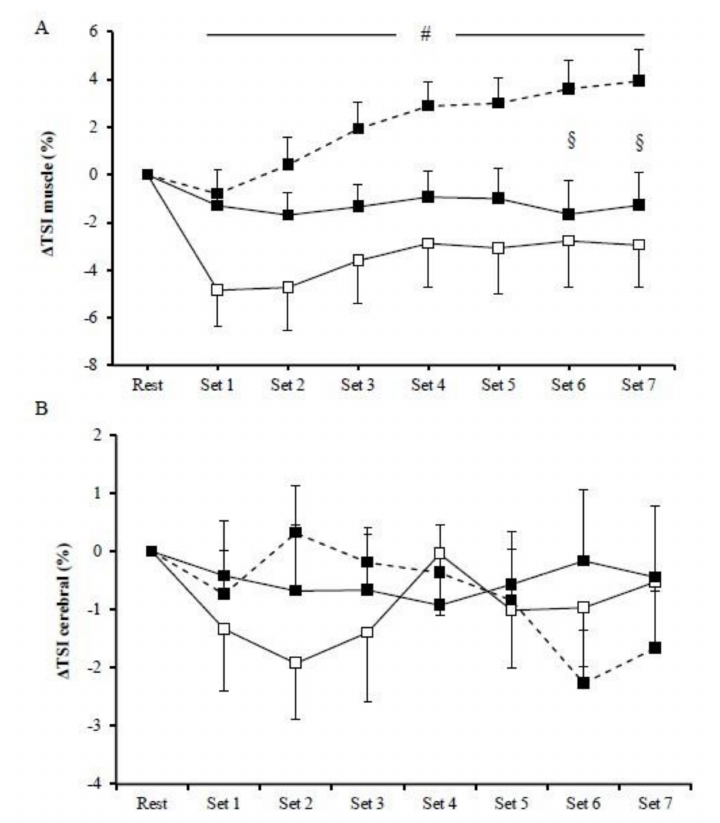
Figure 3. Muscle ( A ) and cerebral ( B ) tissue oxygenation index during the cycling (dash line), the concentric ( (cid:3) ), and the eccentric ( (cid:4) ) exercise. (#) indicates significant difference between the cycling exercise and the concentric exercise; (§) indicates significant difference between the cycling exercise and the eccentric